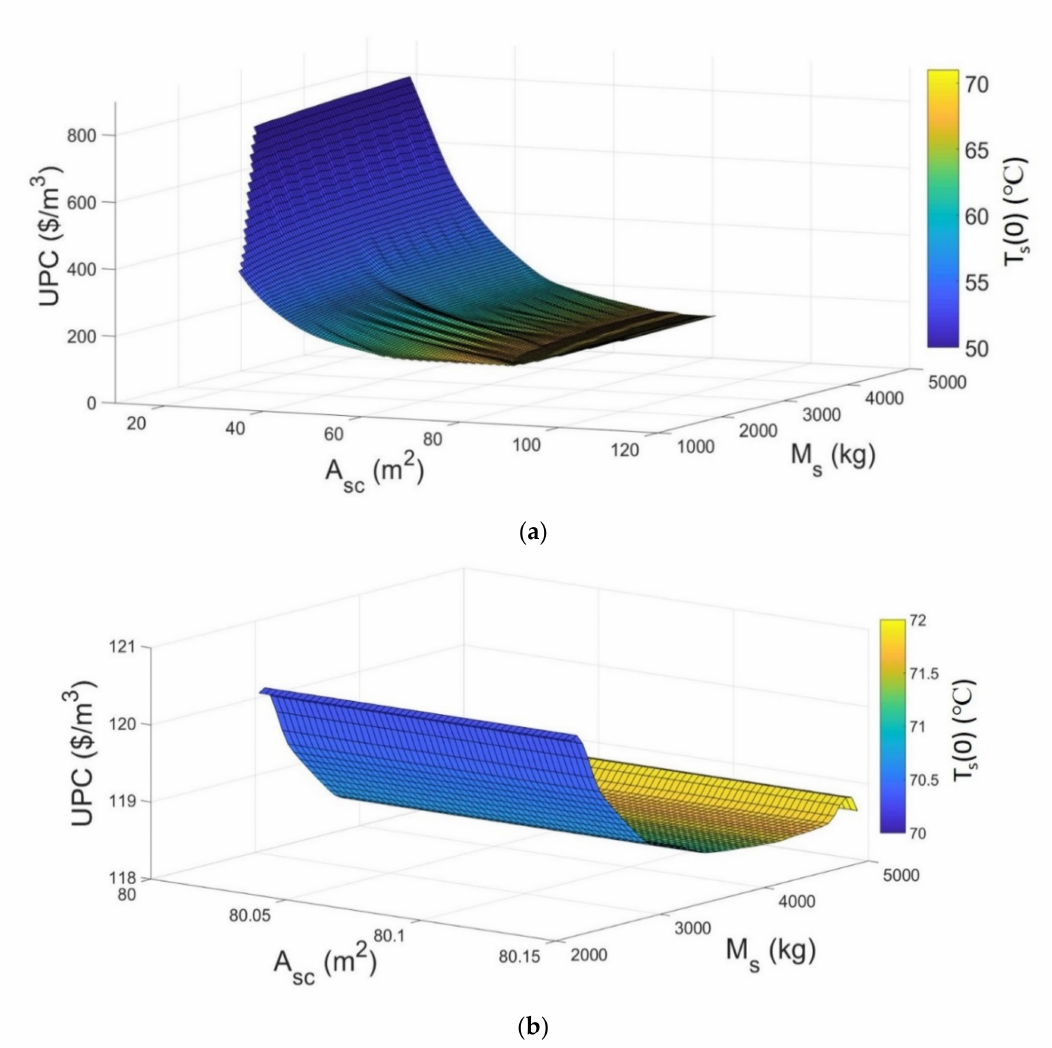
Figure 9. The UPC for the optimization variables of the solar-heated membrane distillation system with ( a ) fmincon and ( b ) full-range